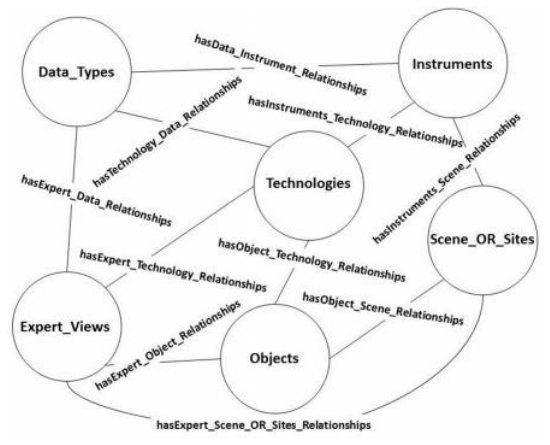
Figure 1: Top-level ontology of COSCH KR